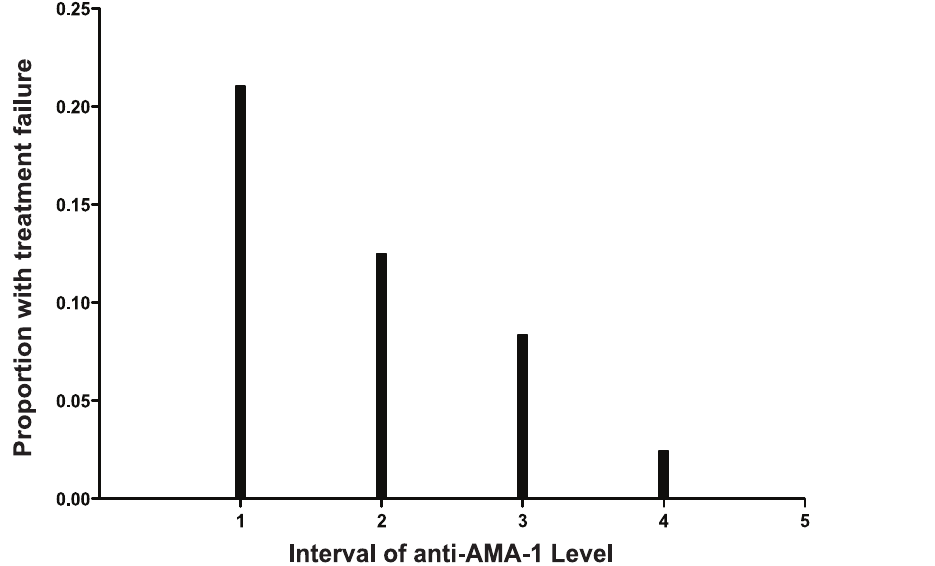
Figure 3. Relationship between anti-apical membrane antigen 1 (AMA-1) antibody levels and risk of treatment failure. A consistent relationship was seen across the range of values observed. Anti-AMA-1 levels (log-transformed) were divided into five equal intervals, each representing a 10-fold increase in level.